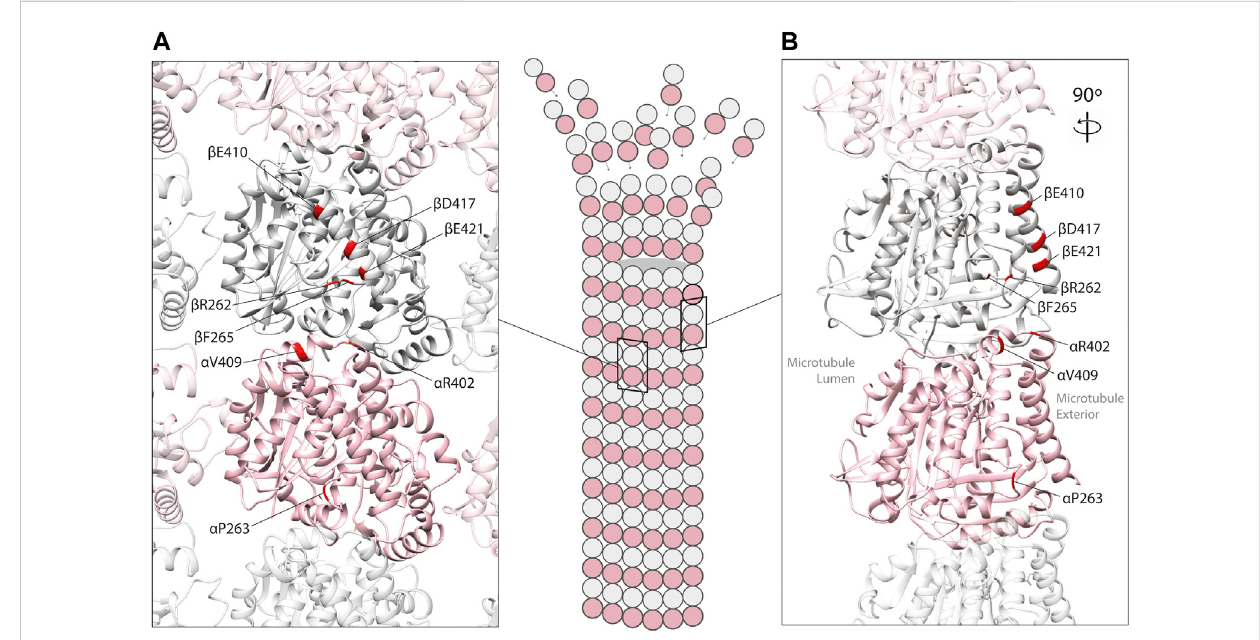
FIGURE 2 In silico homology model of an α / β -tubulin heterodimer (A) facing the exterior surface of a microtubule polymer and (B) a rotated side view of an individual microtubuleproto fi lament (PDB2XRP)(Fournioletal.,2010). α -tubulinisrepresented byapinkribbon, β -tubulininsilver.Unstructured,tubulin carboxy-terminal tails are not shown. Mutated residues shown to effect MAP binding are mapped onto α - and β -tubulin subunits (red).